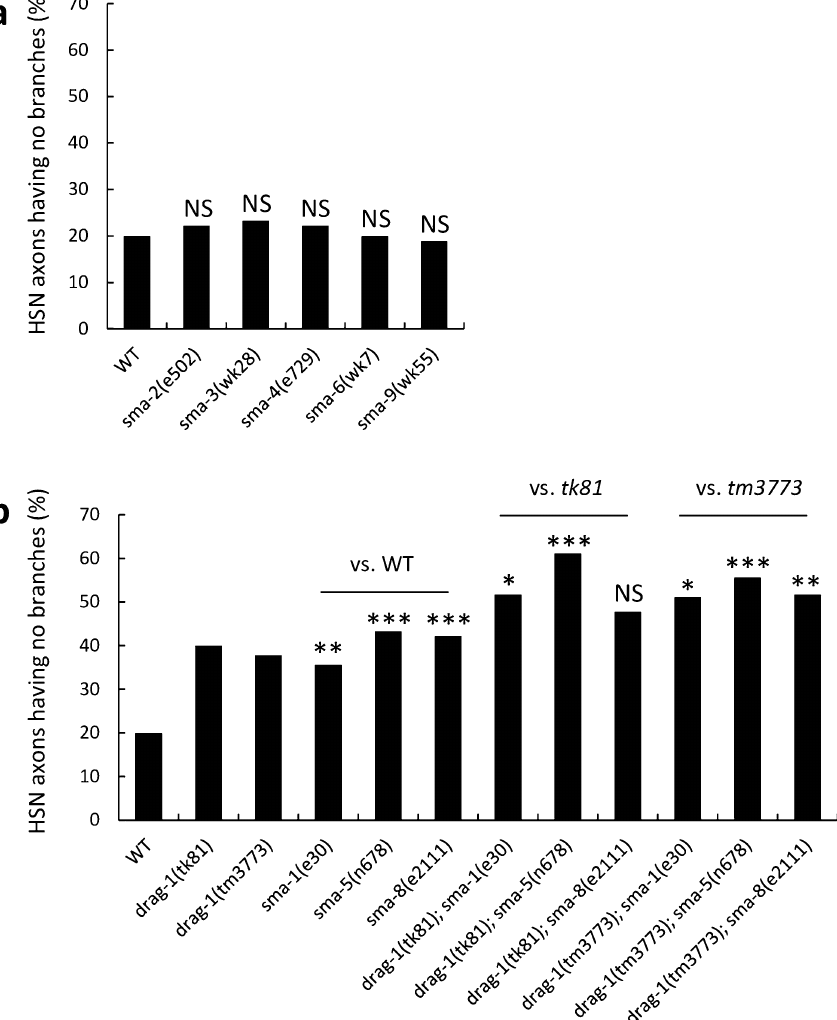
Figure 3. Genetic interactions between drag-1 mutants and sma mutants. Percentages of HSNs having no branches are shown. ( a ) sma-2(e502) , sma-3(wk28) , sma-4(e729) , sma-6(wk7) , and sma-9(wk55) mutants were compared with wild type. ( b ) drag-1(tk81) and drag-1(tm3773) mutants were compared with sma-1(e30) , sma- 5(n678) , and sma-8(e2111) mutants and with double mutants consisting of drag-1(tk81) or drag-1(tm3773) in combination with individual sma mutations. Significant differences were determined by Fisher’s exact test. ***P < 0.001, **P < 0.01, *P < 0.05. NS not significant. n = 180 for each